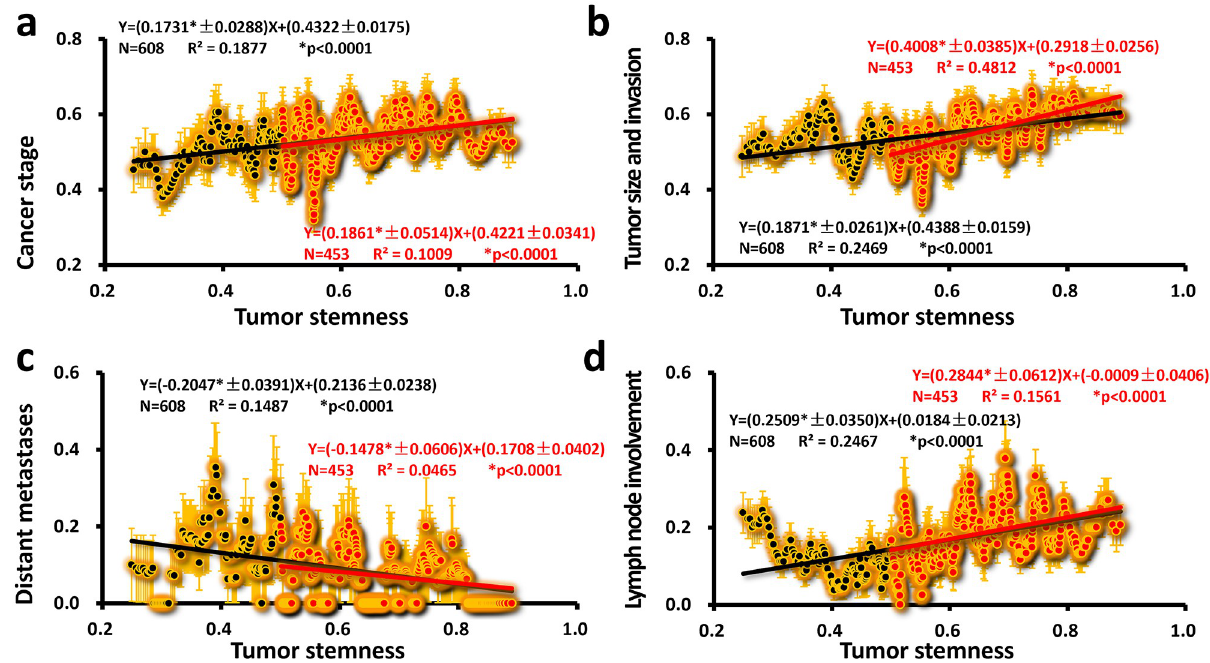
Fig 4. Four clinical data as a function of tumor stemness. The linear regression results of the denoised clinical data (a: cancer stage; b: tumor size and invasion; c: distant metastasis; d: lymph node involvement) and Tumor stemness in all intervals (0, 1) are shown as solid black lines, and black numbers represent the linear regression results on the interval (0.5, 1) with solid red lines and red numbers. The error in orange shows the calculated SEM while denoising. The error of the slope and intercept is directly expressed in the regression equation ± behind the value represents error; N is the total number of data; R 2 is the square of the correlation coefficient; p is the p -value for which the slope is not zero; � means significant).